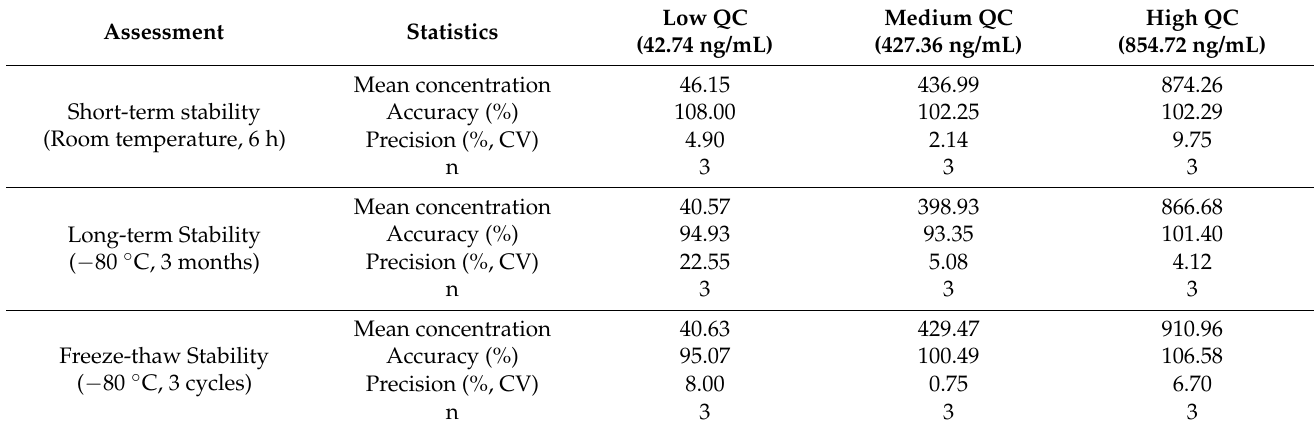
Table 3. Stability tests of T-DM1 in rat plasma under various conditions.